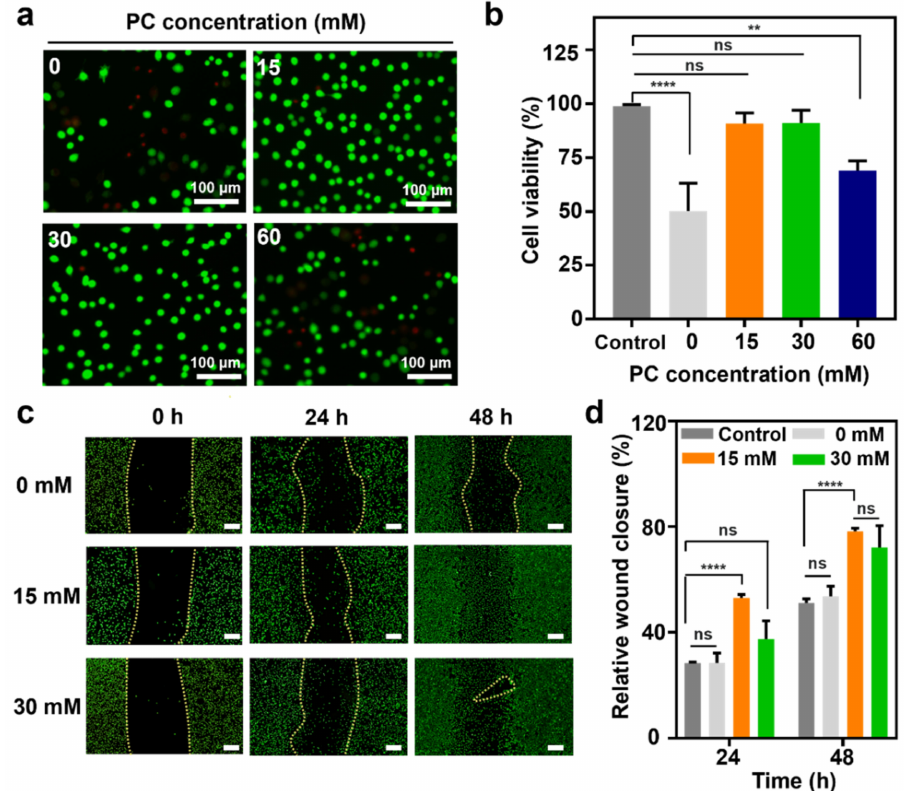
Figure 6. In vitro cell viability and wound scratch assay. ( a , b ) Cell viability test. Scale bar: 100 µ m. ( n = 3). ( c ) Wound scratch assay and wound closure for 0 mM, 15 mM, and 30 mM PC-containing APC hydrogels. Scale bar: 200 µ m. Yellow lines indicate scratched area. ( d ) Wound-healing percentage ( n = 3). All statistical significance and p values are determined by one- and two-way ANOVA followed by Tukey’s post-hoc test. ** p < 0.01, **** p < 0.0001; ns denotes not